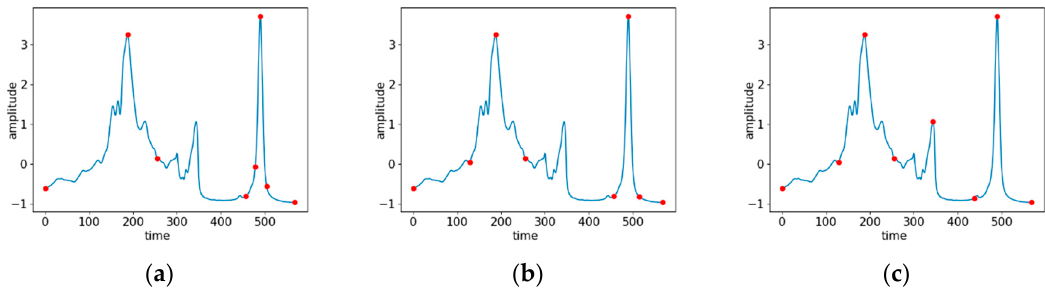
Figure 2. Influence of parameter 𝜏 selection for data set OliveOil, which is 𝜏 = 1 ( a ), 𝜏 = 25 ( b ) and 𝜏 = 50 ( c ), respectively.